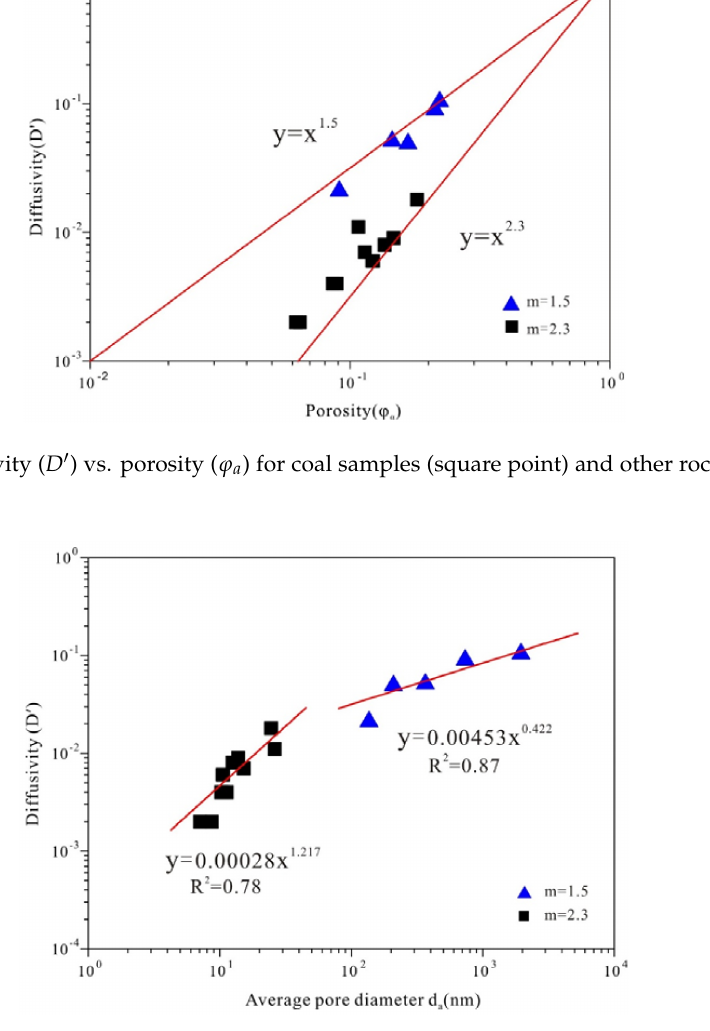
Figure 8. Diffusivity (D (cid:48) ) vs. average pore diameter (da) for coal samples (square point) and other rocks (triangle